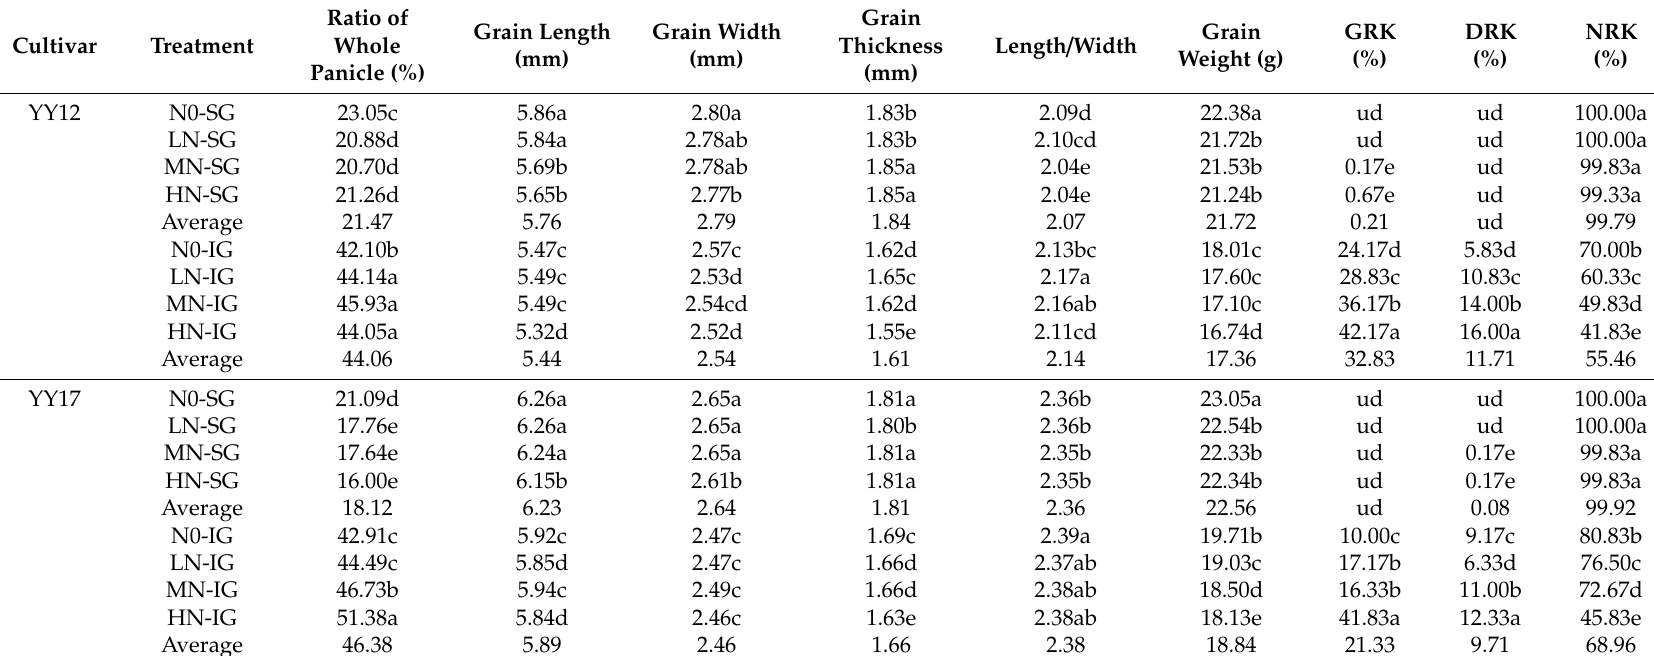
Table 4. Characteristics of superior and inferior grains under di ff erent nitrogen